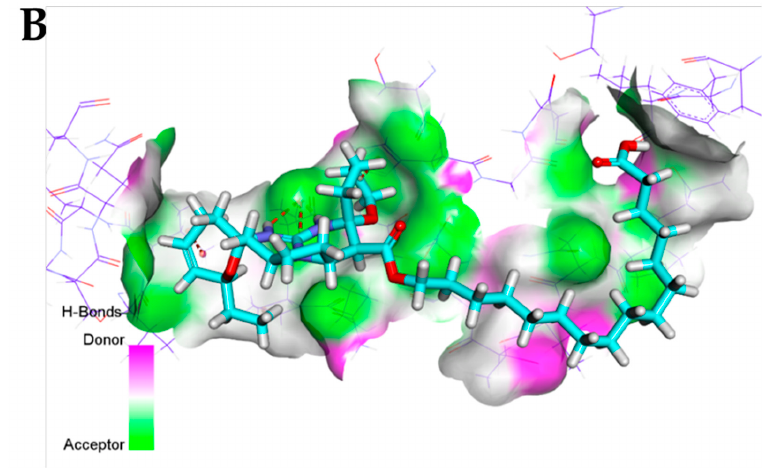
Figure 14. ( A ) Compound 7 docked into the active site of COVID-19 membrane glycoprotein. ( B ) Mapping surface showing compound 7 occupying the active pocket of COVID-19 membrane glycoprotein.